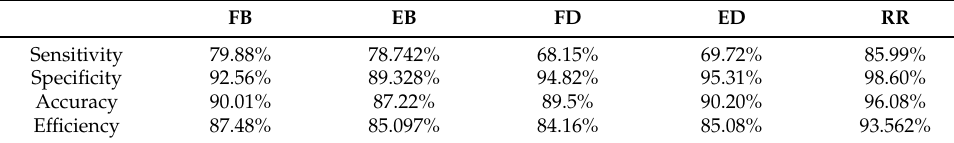
Table 18. Classifier performance parameters for the training stage.